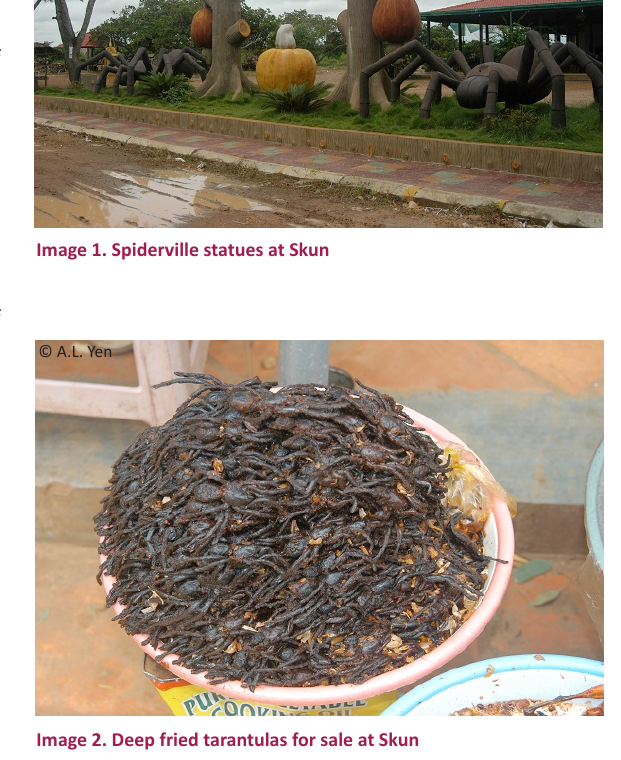
Image 2. Deep fried tarantulas for sale at Skun